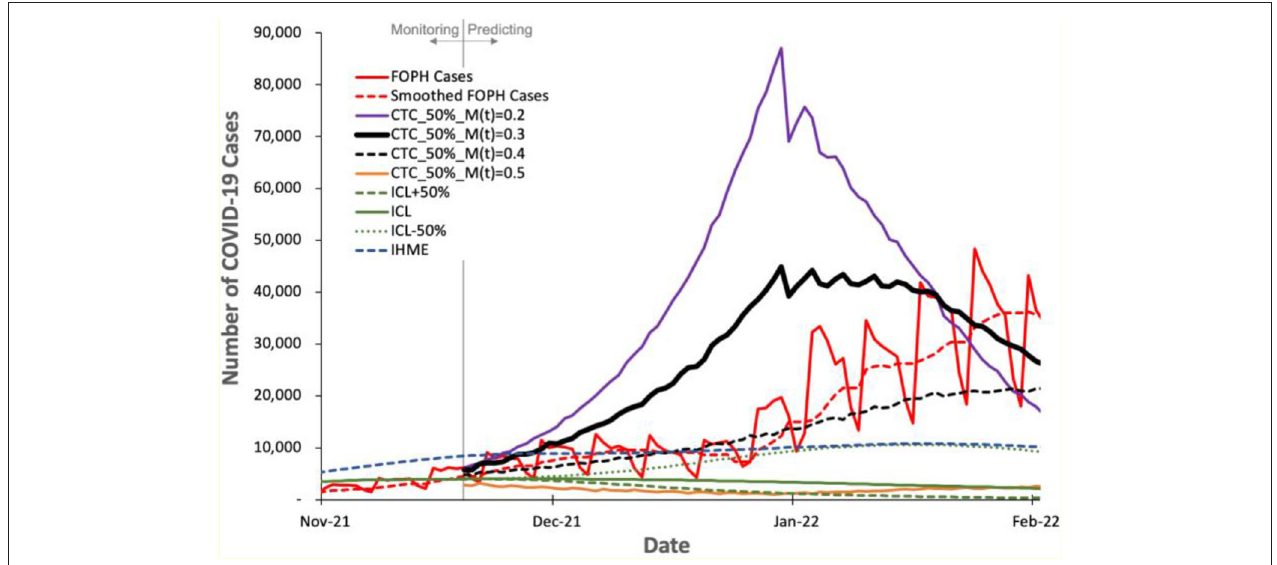
FIGURE 7 | Predicted number of COVID-19 cases by COVIDHunter model and other two state-of-the-art models, ICL and IHME, compared to the real number (FOPH Cases) of COVID-19 cases released after performing the prediction.